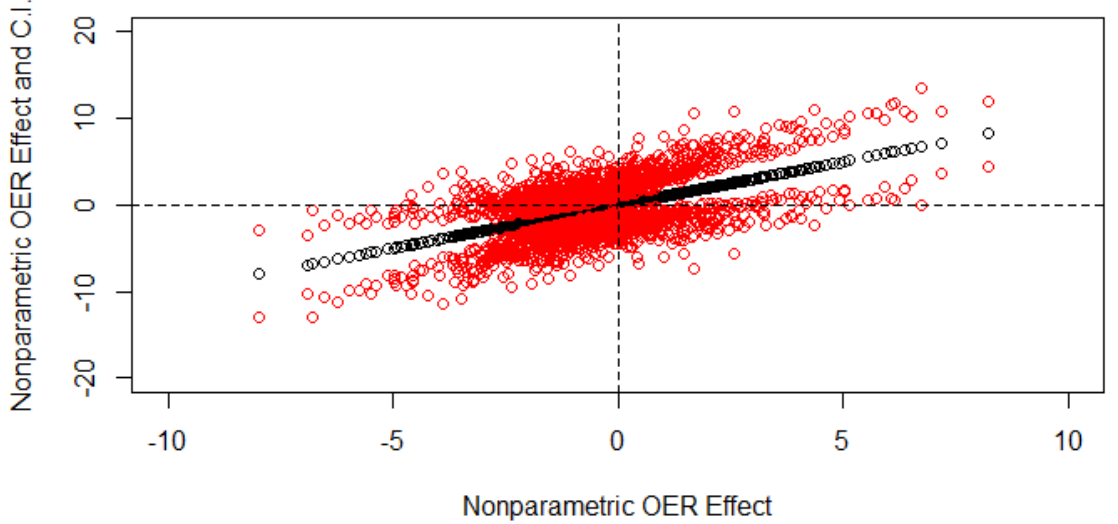
Figure 2. A 45 degree gradient plot of the OER effect from nonparametric Model